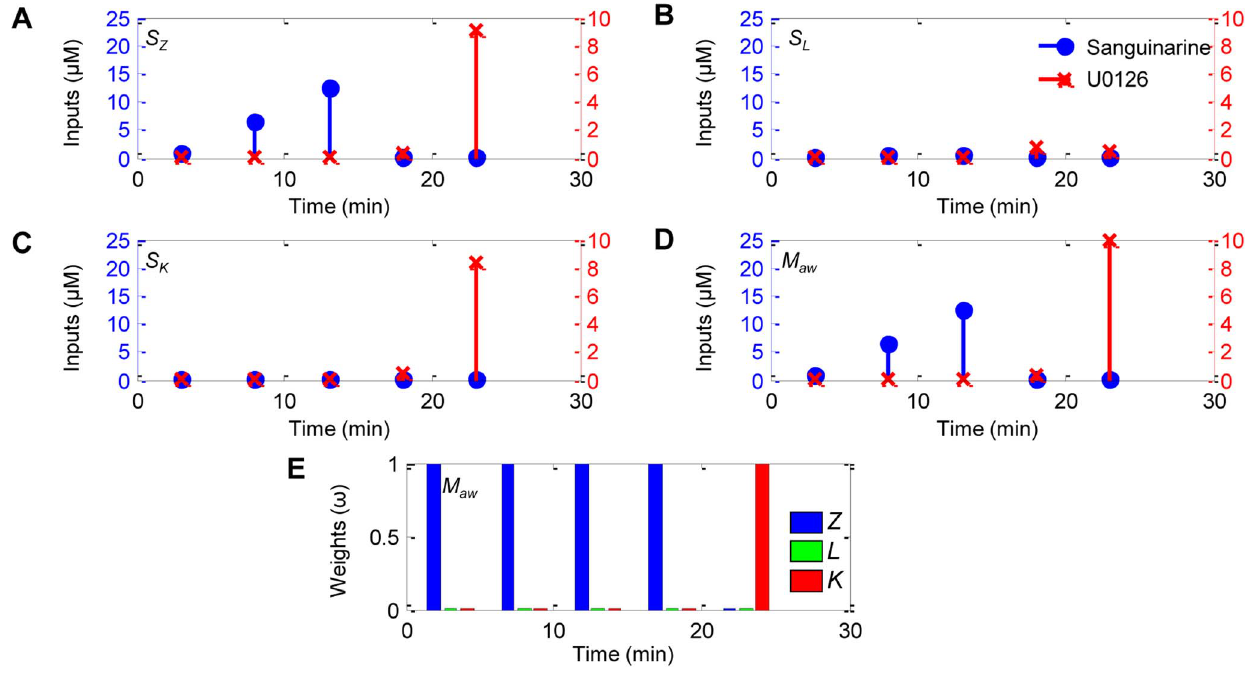
Figure 5. Invitro experiments demonstrate superior target tracking performance by M aw ; corroborates observed insilico trends. ( A – D ) Control input dosing regimens for single-model controllers ( S Z , S L and S K ) and the multiple-model controller with adaptive Akaike weights ( M aw ). ( E ) Akaike weights for M aw .